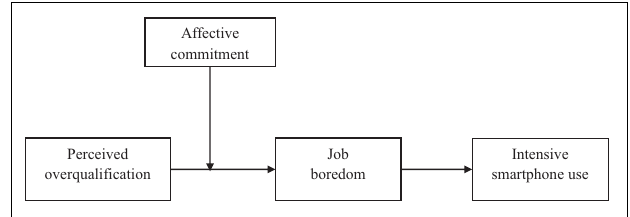
FIGURE 1 | Proposed research